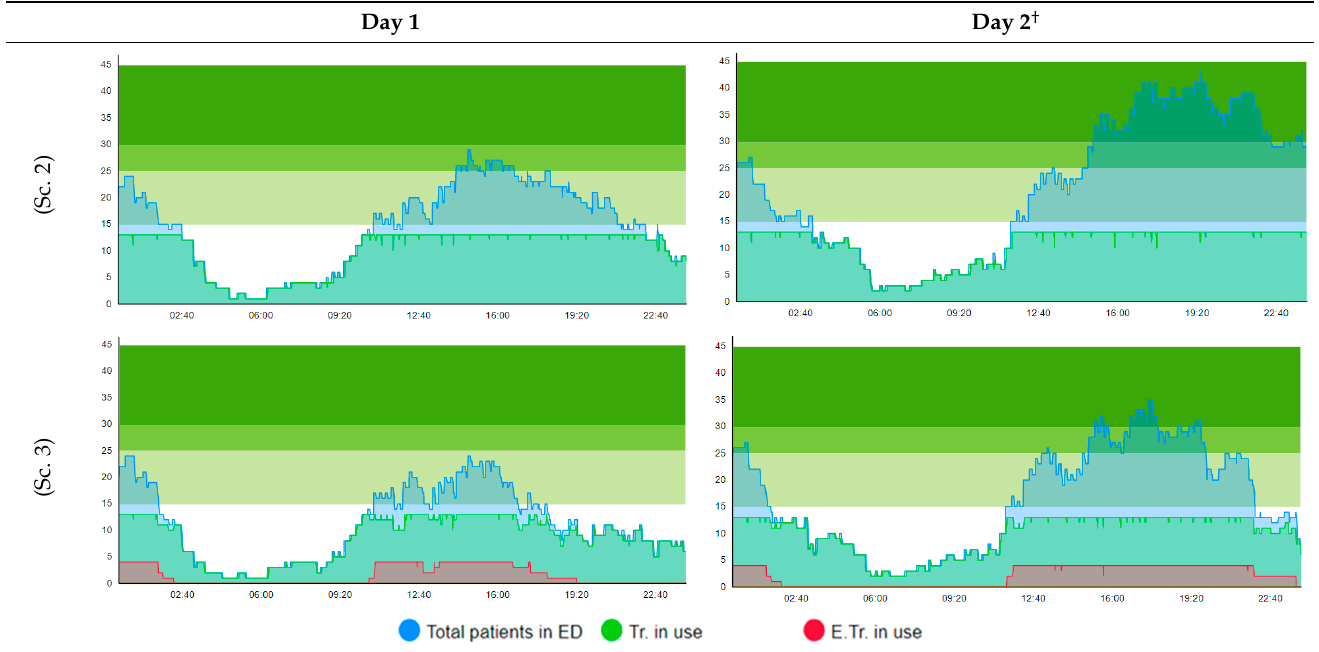
Table 10. Simulation output crowding graphs for comparing Sc.3 with Sc.2.